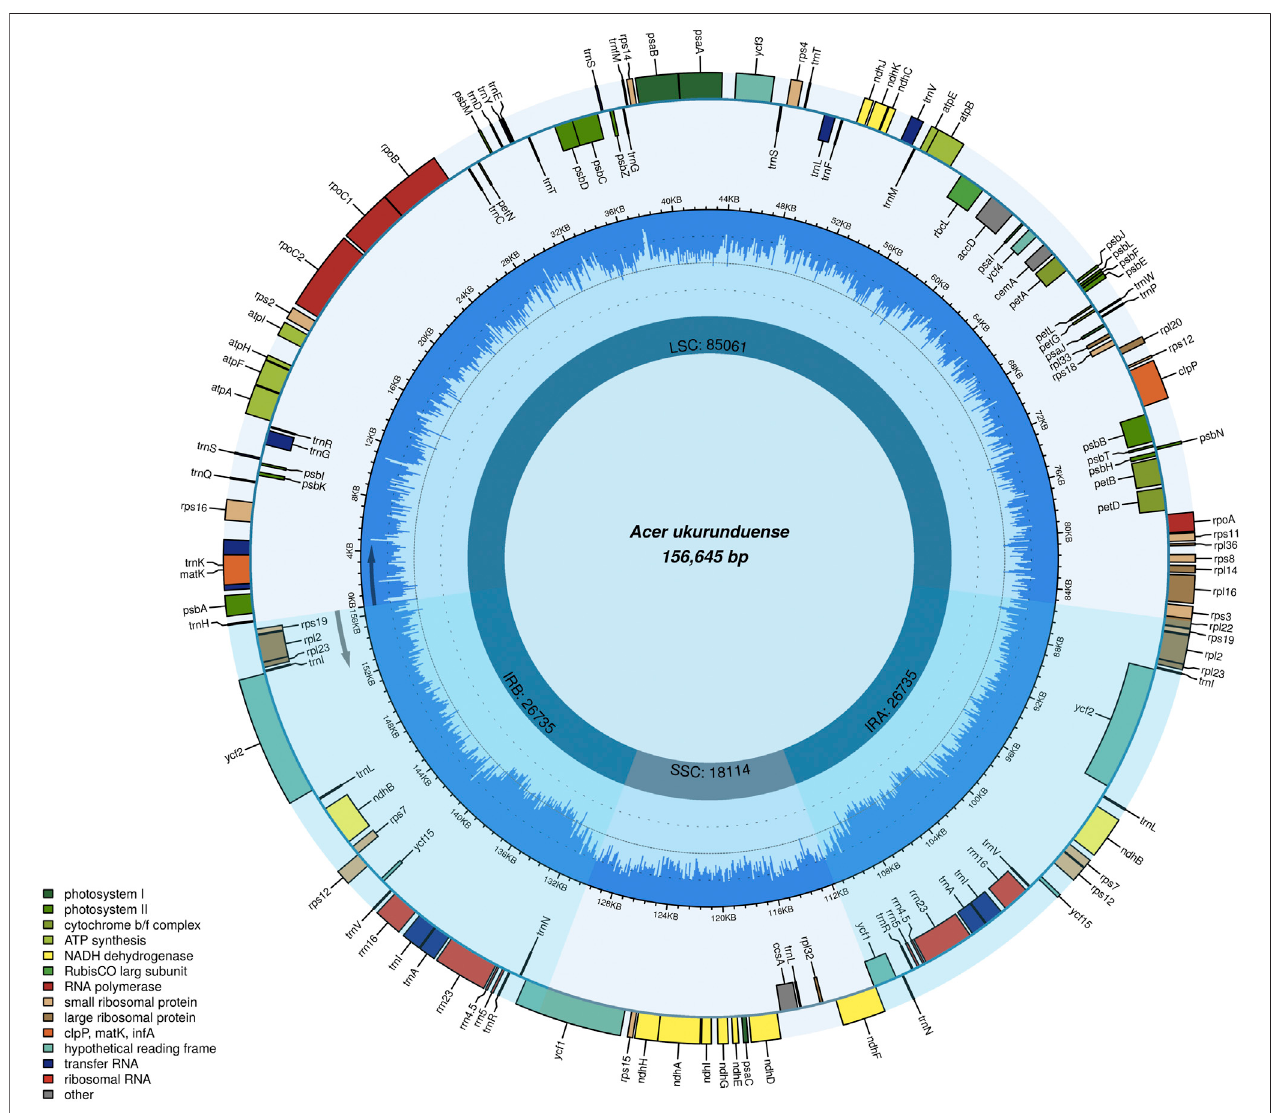
FIGURE 1 | Gene map of the A. ukurunduense complete cp genome. Genes drawn within and out of the circle are transcribed in the clockwise and anticlockwise directions, respectively. Genes are color- fi lled, which represents different functions.